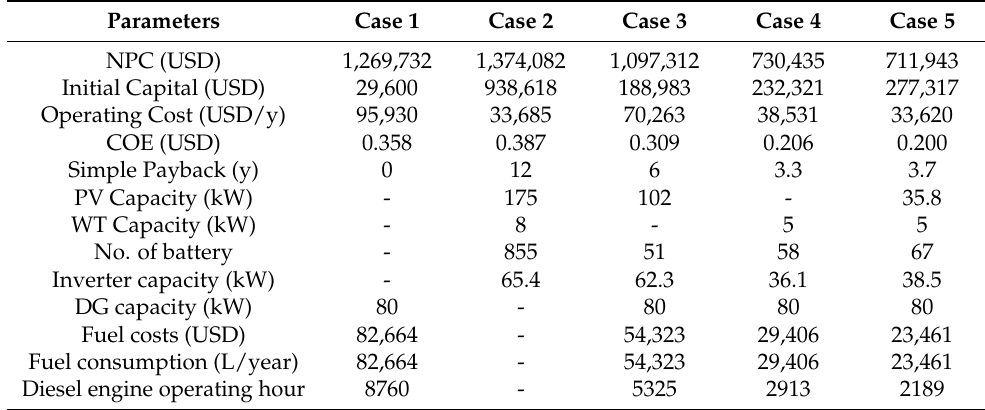
Table 3. Simulation